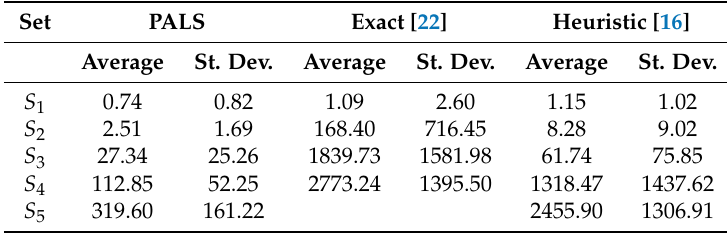
Table 2. Average and standard deviation of the CPU times by